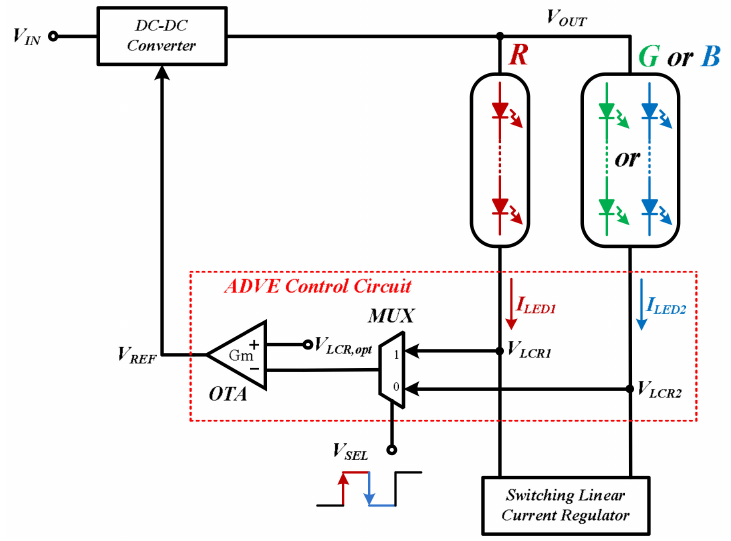
Figure 9. Proposed adaptive driving voltage and energy-saving control circuit.